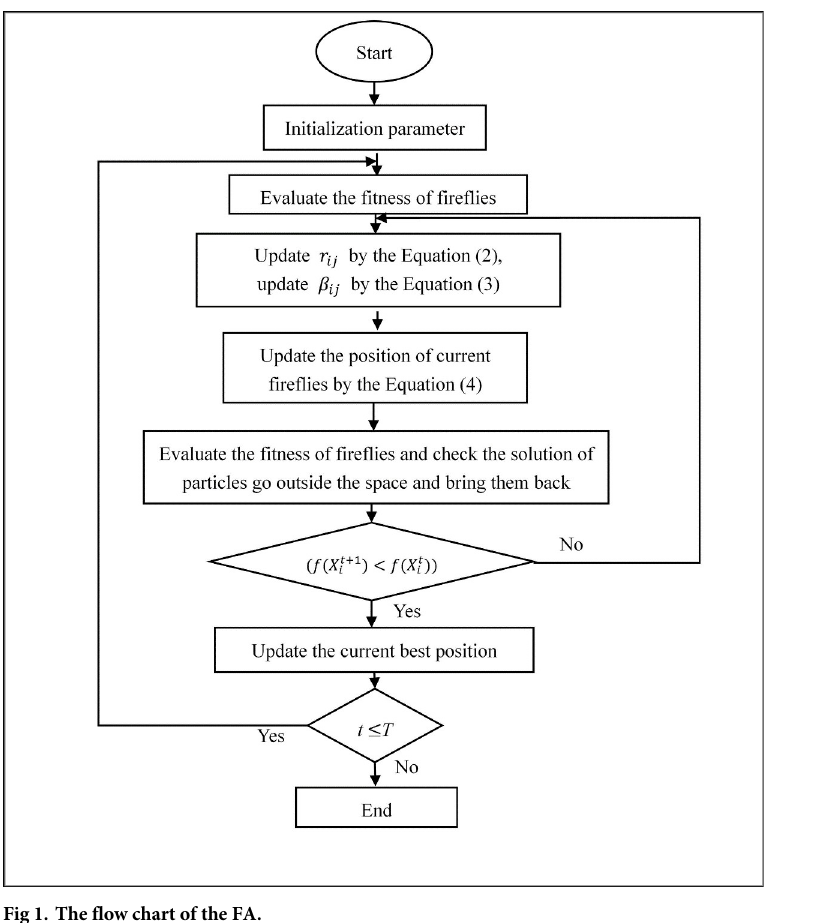
Fig 1. The flow chart of the